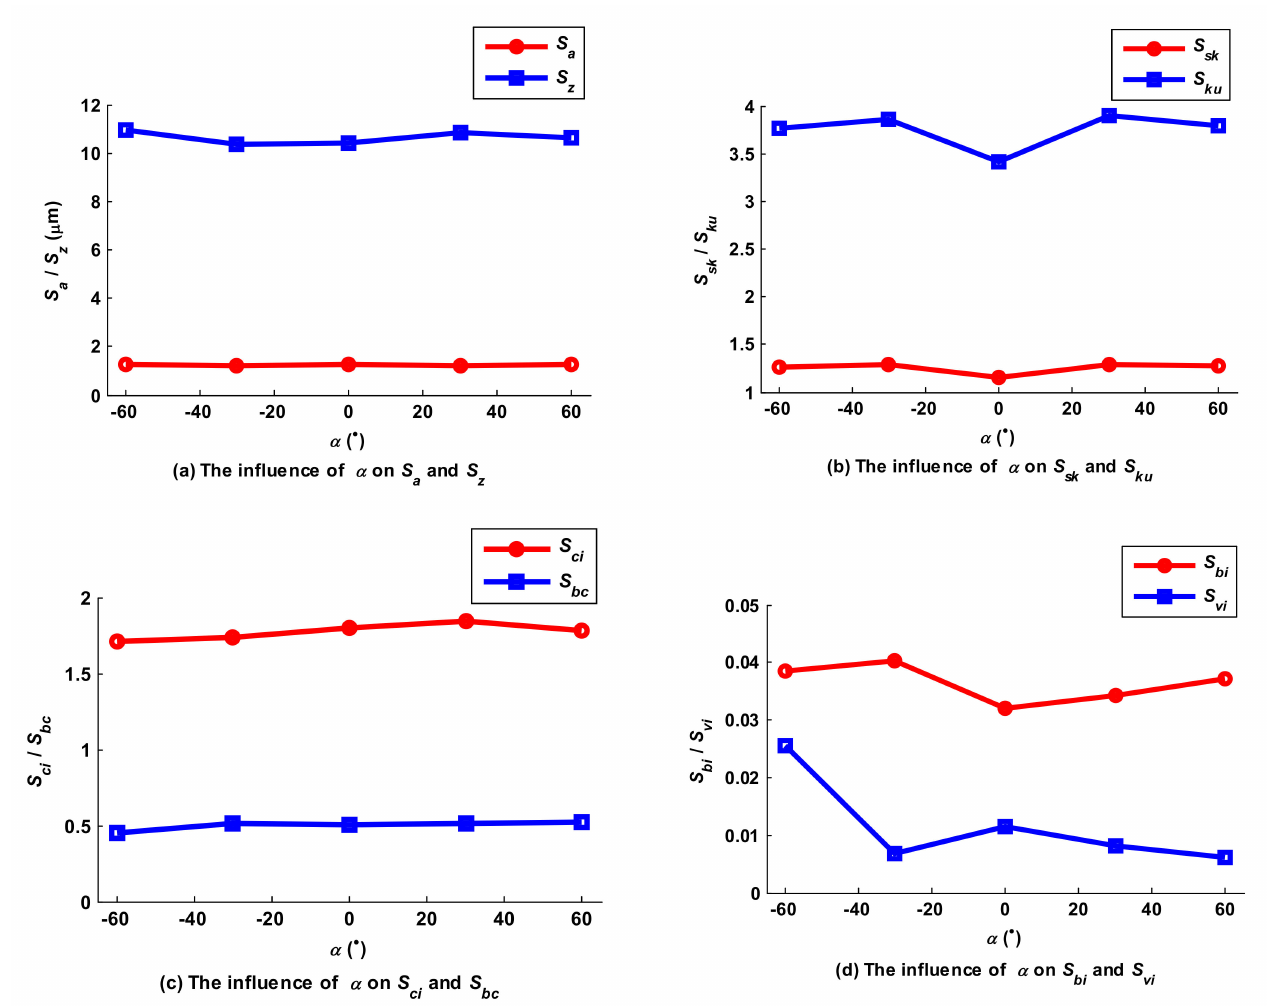
Figure 23. Influence of the tilt angle on Ball-end trochoidal milled surface